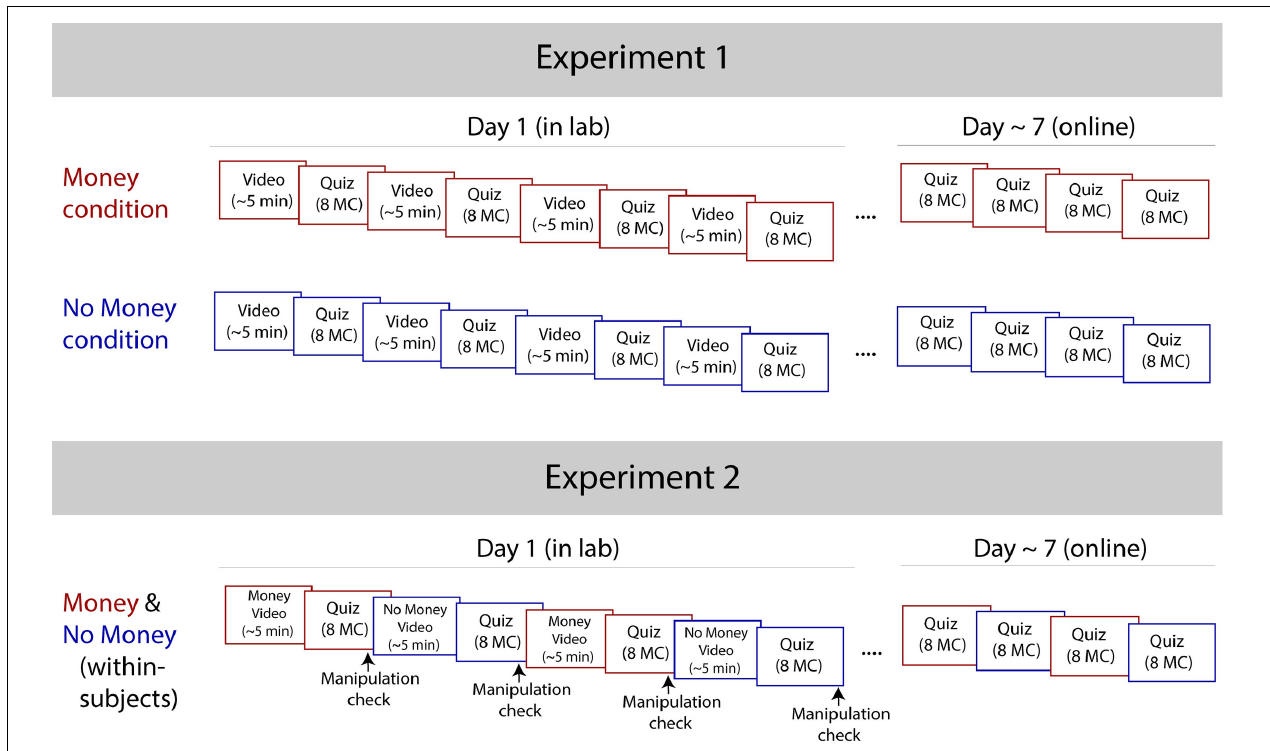
FIGURE 1 | Design of Experiment 1 and Experiment 2. Across experiments, participants were shown the same videos (approximately five minutes each) and took the same multiple-choice (MC) quiz questions. Each video was immediately followed by a corresponding quiz. All participants saw their final score at the end of the lab experiment (Day 1) but received no feedback after the online follow-up (Day ∼ 7). In Experiment 1, participants were either assigned to the Monetary condition or No Incentive condition, but all participants watched the videos in the same order. In Experiment 2, all participants received the same instructions, where two of the videos were incentivized monetarily and the other two were not. Video order was randomized across participants for Experiment 2. In Experiment 2, after each quiz, participants also received a manipulation check (four total) to ensure they remembered the preceding video type (Monetary or No